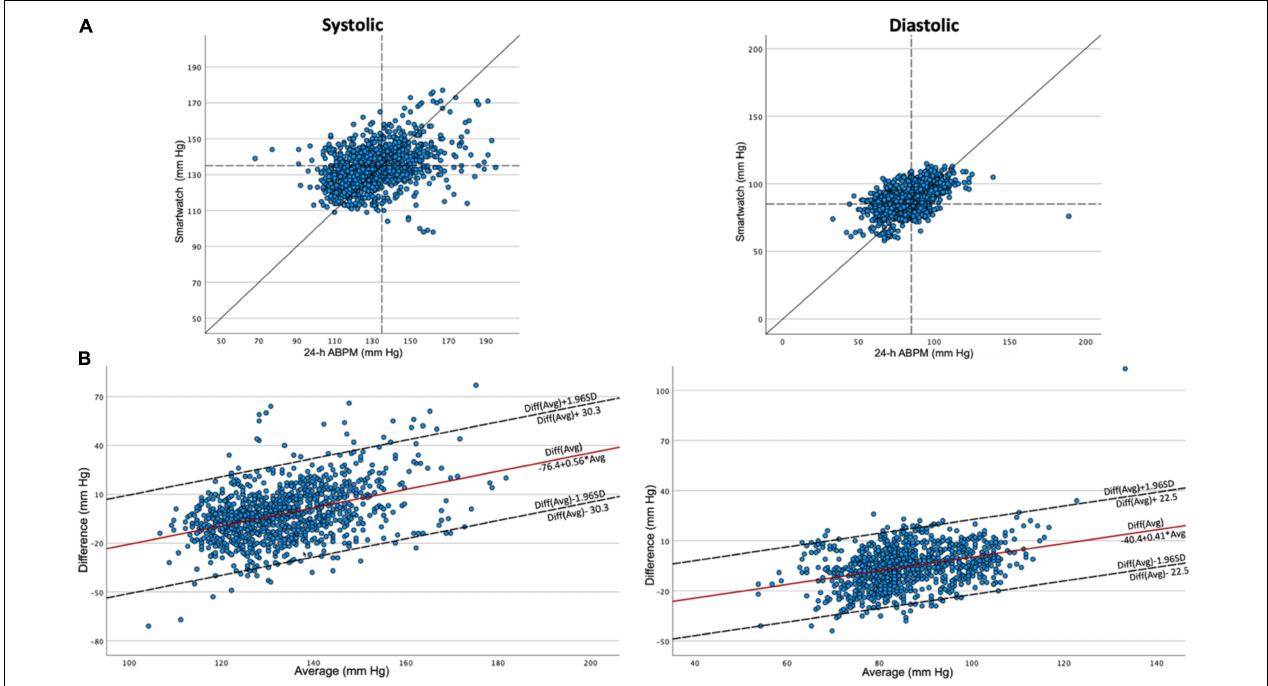
FIGURE 2 | Scatterplots and Bland–Altman plots. Scatterplots (A) and Bland–Altman plots (B) for systolic and diastolic blood pressure measurements. In the scatterplots, cut-offs of 135 and 85 mm Hg are depicted as dashed lines. 24-h ABPM: 24-h ambulatory blood pressure monitoring. SD, standard deviation.